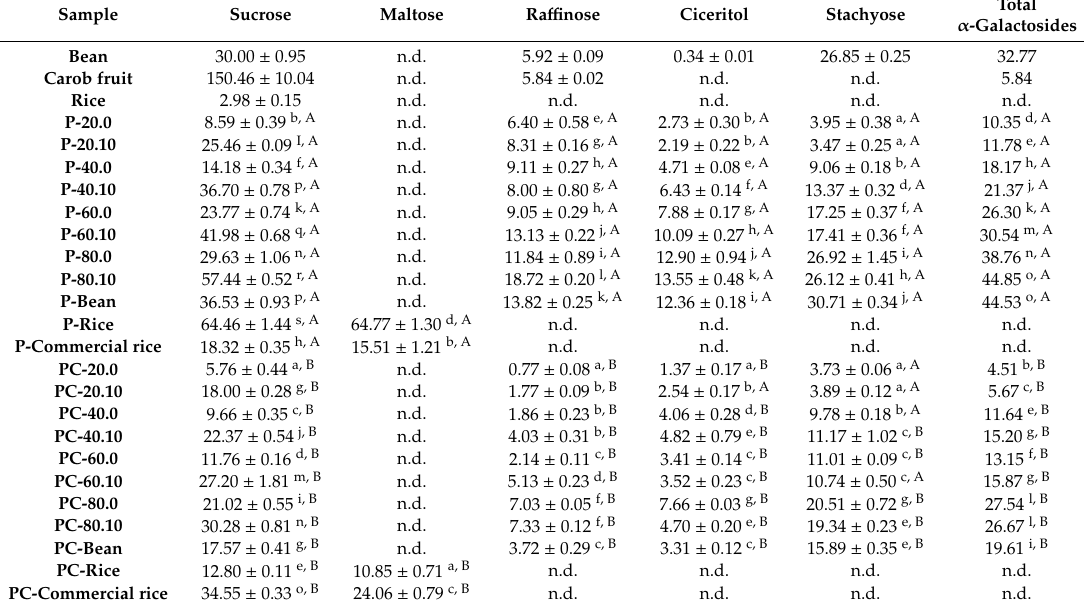
Table 3. Content of soluble sugars, ciceritol, and α -galactosides (mg / g dry weight) in raw materials and in the uncooked (P-) and cooked (PC-) fettuccine, as well as in the commercial rice pasta. Sample Sucrose